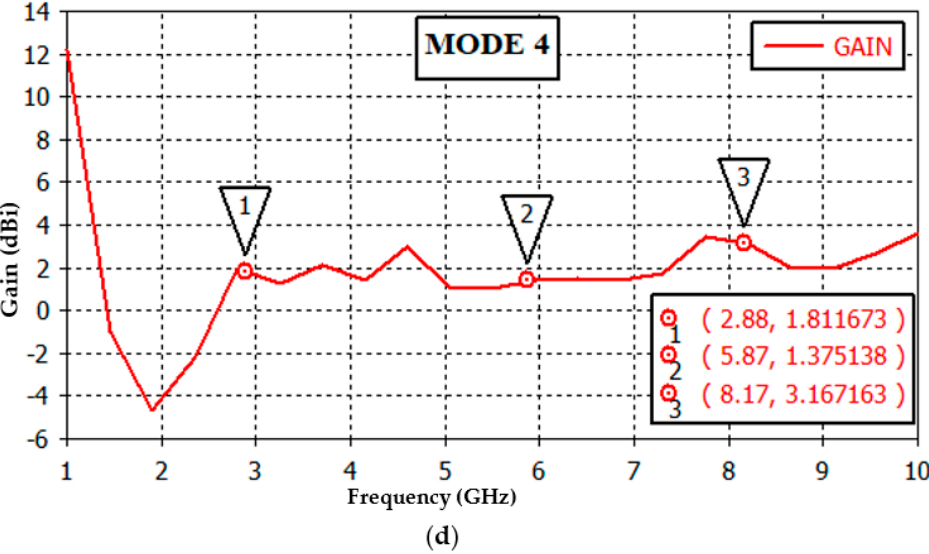
Figure 11. The two ‐ dimensional gain pattern plots for the antenna at frequencies ( a ) 4.36 GHz, 7.78 GHz (MODE 1), ( b ) 3.56 GHz, 6.89 GHz (MODE 2), ( c ) 3 GHz, 6.2 GHz (MODE 3), ( d ) 2.88 GHz, 5.87 GHz, and 8.17 GHz (MODE 4).